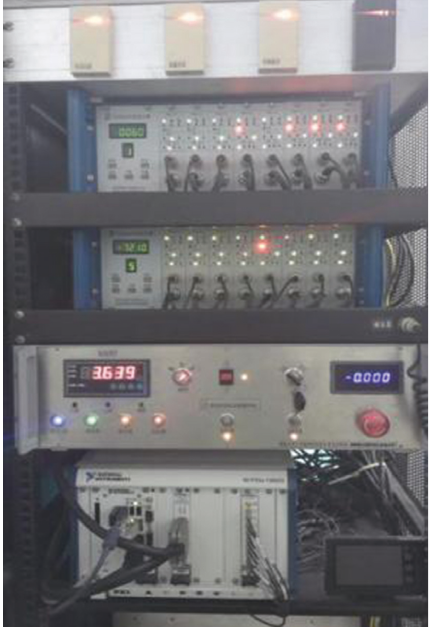
Figure 8: Data collection system.